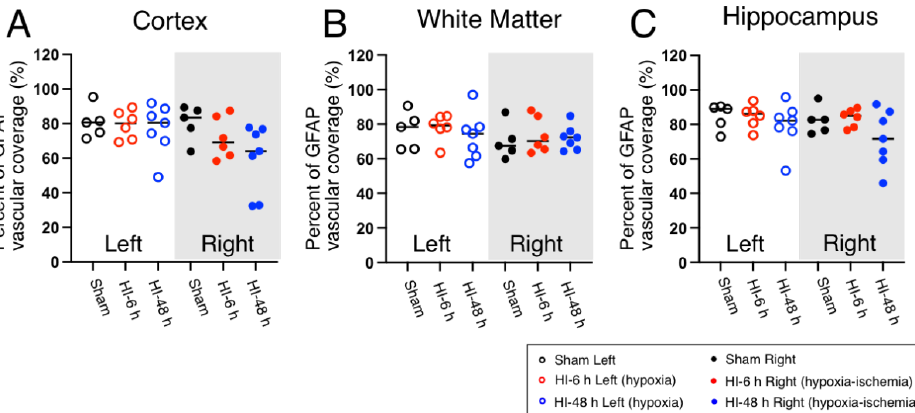
Figure 3 . Quantification of astrocyte coverage in the cerebral cortex ( A ), white matter ( B ), and hippocampus ( C ) on the left hypoxic and right HI sides in the brain of the neonatal rats in the Sham, HI-6 h, and HI-48 h groups. Quantification of astrocyte coverage shown by percent of GFAP vascular coverage in the cerebral cortex ( A ), white matter ( B ), and hippocampus ( C ) of left hypoxic and right HI sides of rat brain in Sham (left; black open circles, right; black closed circles), HI-6 h (left; red open circles, right; red closed circles), and HI-48 h (left; red open circles, right; red closed circles). Values median and dot plots. The quantification was based upon immunohistochemical images found in Supplementary Figure S2.